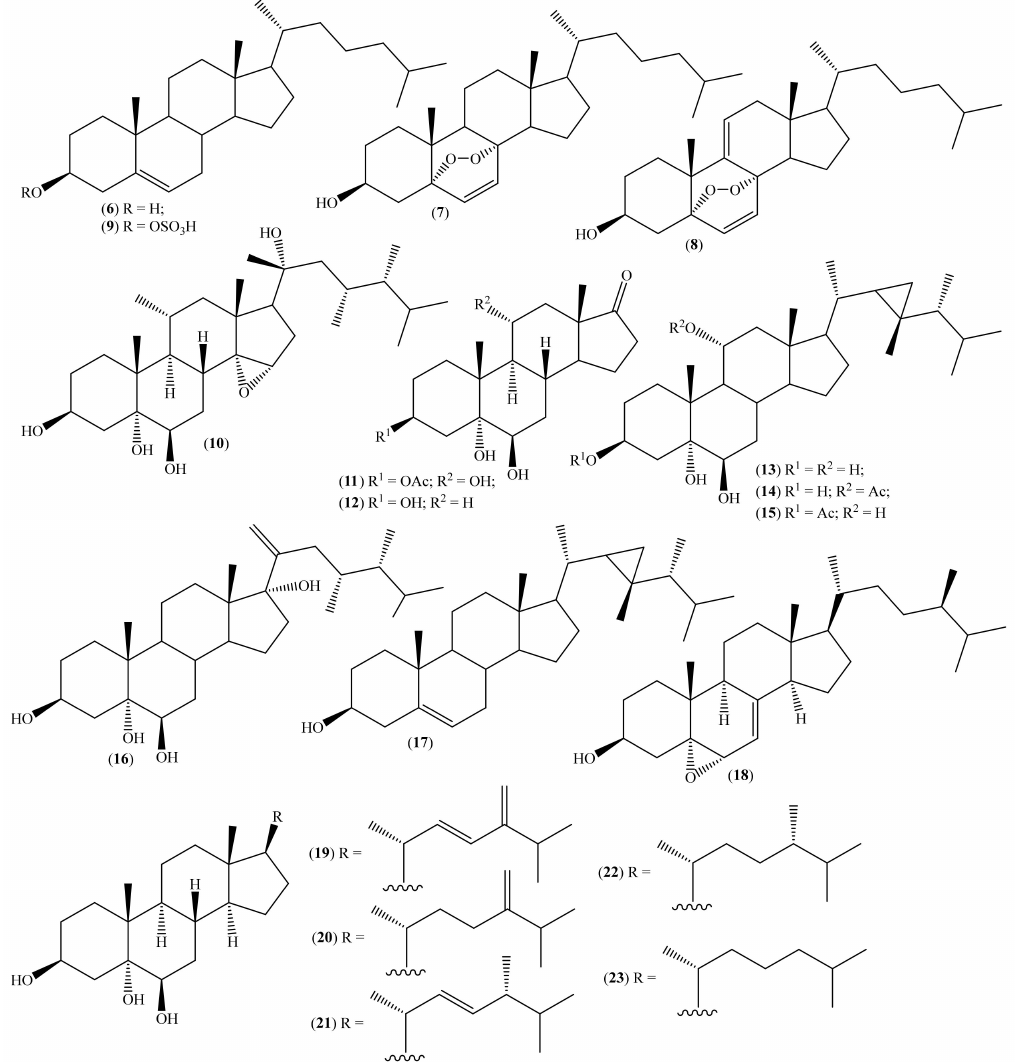
Figure 2. Chemical structure of steroid derivatives isolated from marine